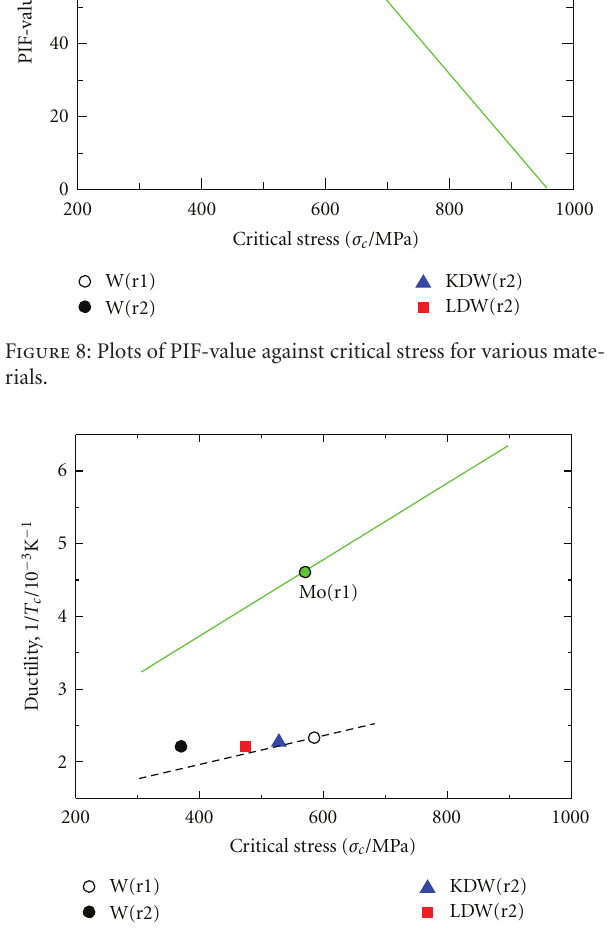
Figure 9: Plots of ductility (1 / T c ) against critical stress for various